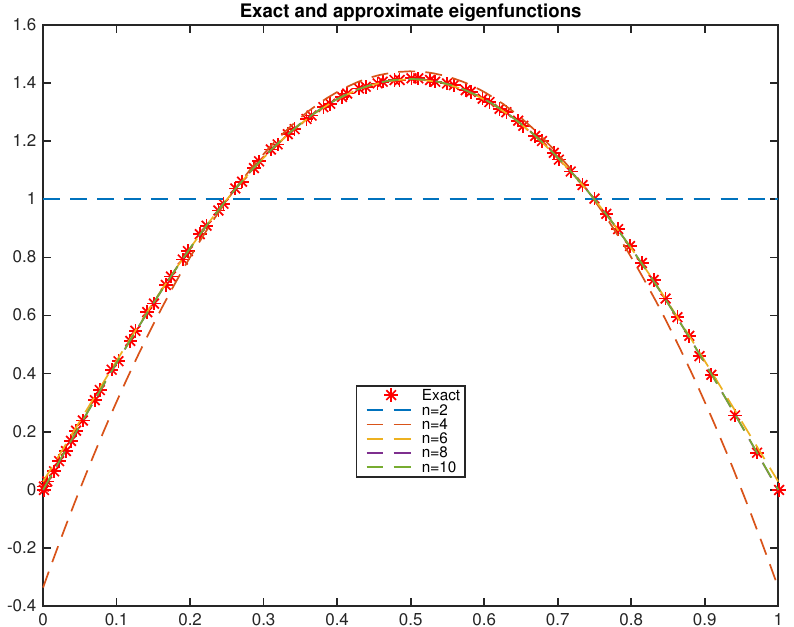
Figure 2. Exact and approximate eigenfunctions for the kernel K ( x , ξ ) = cos ( π ( x + ξ )) over [ 0,1 ] 2 at various truncation